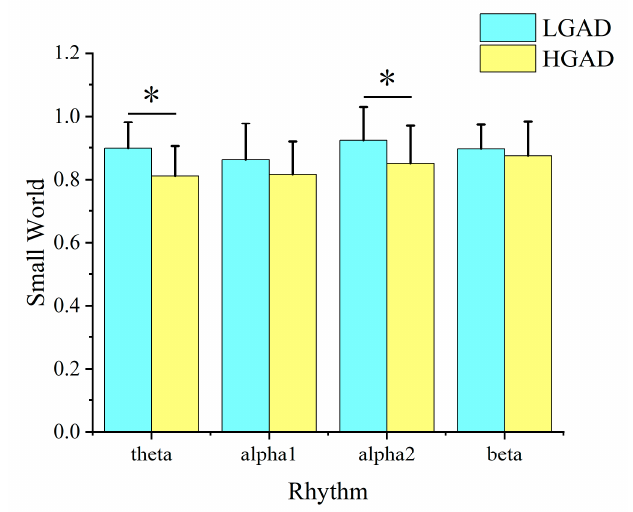
Figure 4. Small-world attribute analysis results of LGAD and HGAD in theta, alpha1, alpha2, and beta rhythms. Among them, the column represents the size of the value, and * represents the statistical difference between the two groups of characteristic values at this location ( p <